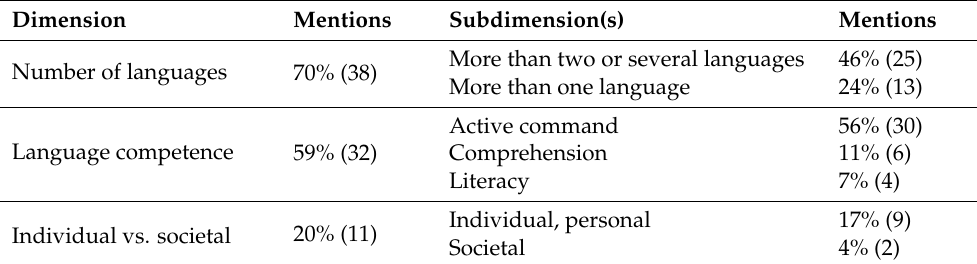
Table 6. Main dimensions and subdimensions of participants’ conceptualization of multilingualism. Mentions are given as a percentage of the total number of participants, followed by the absolute number of mentions. More than one theme or subtheme can be present in a single participant’s